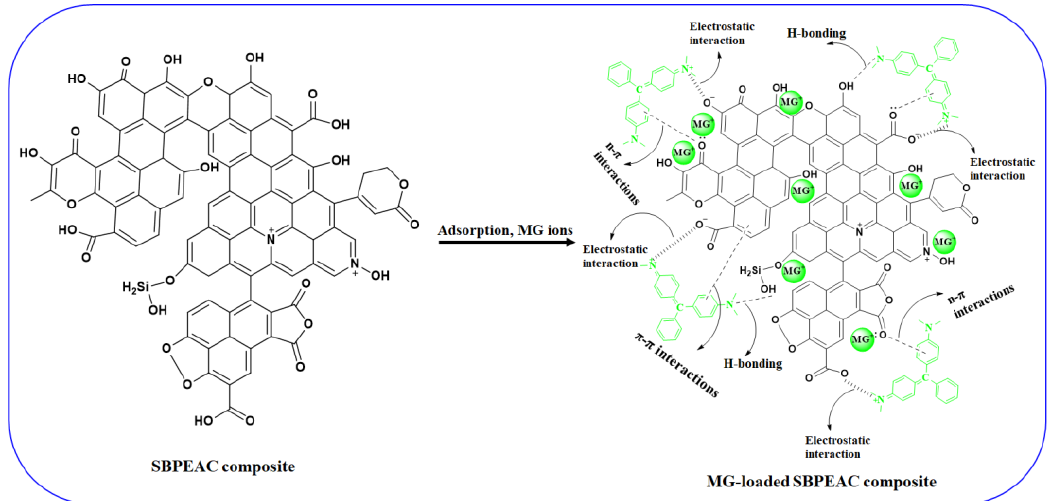
Figure 5. Adsorption mechanism of MG onto SBPEAC composite.